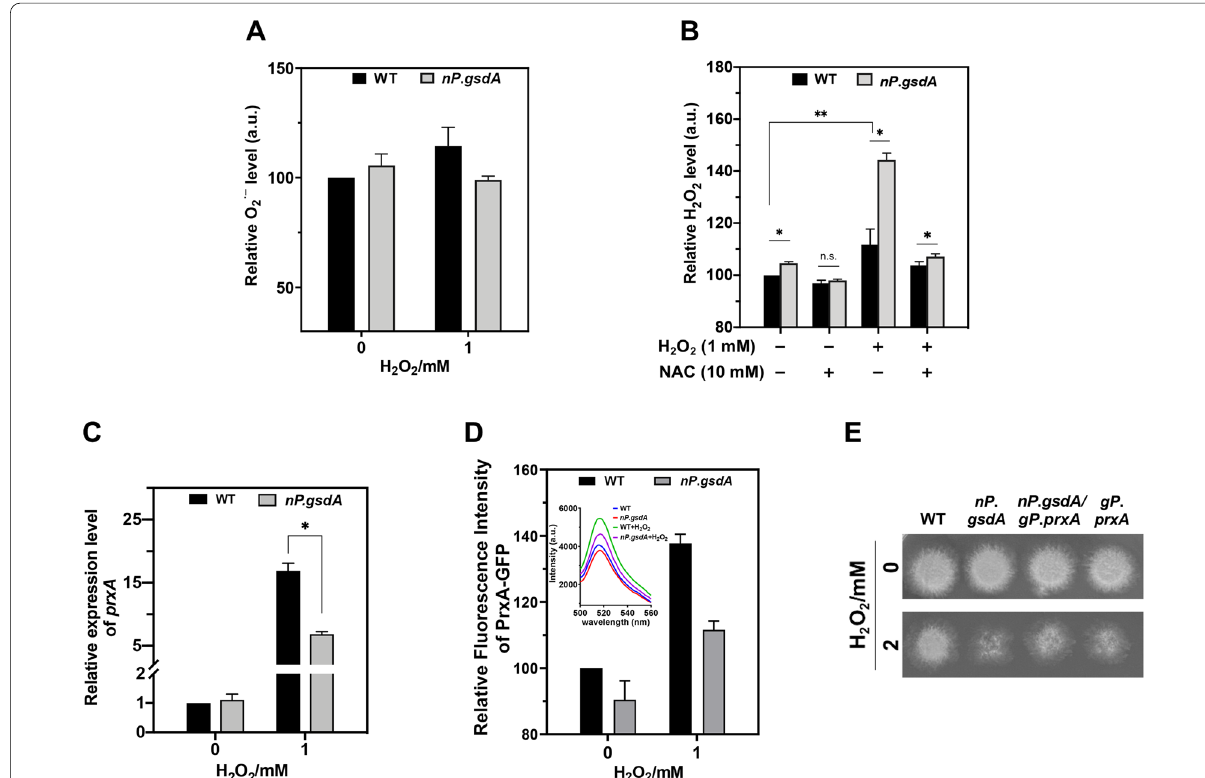
Fig. 3 prxA suppression is responsible for the impairment of fungal resistance to H 2 O 2 in G6PD-overexpression strains. All cultivations used NO 3 − as the sole nitrogen source. A , B Quantification analysis of intracellular O 2 ·− and H 2 O 2 in WT (WT_ pyrG ) and nP . gsdA . After precultivation, both strains were exposed to 0 or 1 mM H 2 O 2 for 30 min followed by addition of ROS fluorescent probes. The ROS scavenger NAC (10 mM) was applied 1 h before the probe incubation. Fluorescence intensities of BES-So-AM and BES-H 2 O 2 -Ac were used to measure the level of intracellular superoxide and H 2 O 2 , respectively. All values were normalized by that in the unstressed WT (set to 100) (mean SD; n 3, * P < 0.05, **P < 0.001, one-way ANOVA). C ± = Relative expression levels of prxA in WT (WT_ pyrG ) and nP . gsdA . Strains were precultivated for 16 h, and then exposed to 1 mM H 2 O 2 for 30 min. The level of prxA in WT without H 2 O 2 -treatment was set to 1 (mean SD; n 3, * P < 0.05, one-way ANOVA). D Relative Prx-GFP levels in the WT (P_Gfp) ± = and nP . gsdA ( nP . gsdA /P_Gfp) strains. Inset, fluorescence spectra of Prx-GFPs from the corresponding cell lysates. After preculture, both strains were exposed to 0 and 1 mM H 2 O 2 for 2 h. Cell lysates (1 mg/ml) were used for fluorescence analysis. E Effects of constitutive expression of prxA on fungal oxidative resistance. Conidia (1 10 5 ) of the strains were spotted and cultivated for 2 days on NO 3 − -MM plates with or without 2 mM H 2 O 2 . Newly × constructed strains are as follows: gP . prxA (replacing prxA promoter with gpdA promoter) and nP . gsdA / gP . prxA (replacing gsdA promoter with niaD promoter in gP . prxA